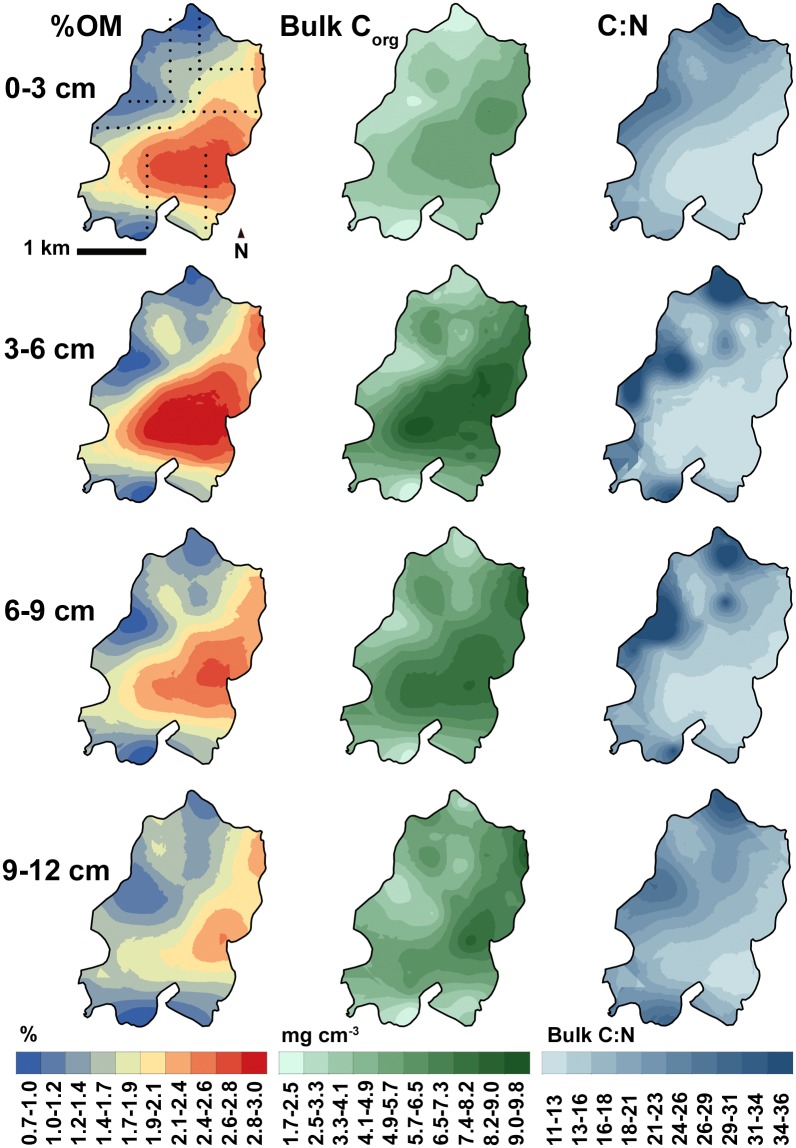
Organic matter, Corg, and bulk C:N distributions by bed depth interval within the meadow.Transect sites are shown in the first Fig; the maps were generated by kriging.